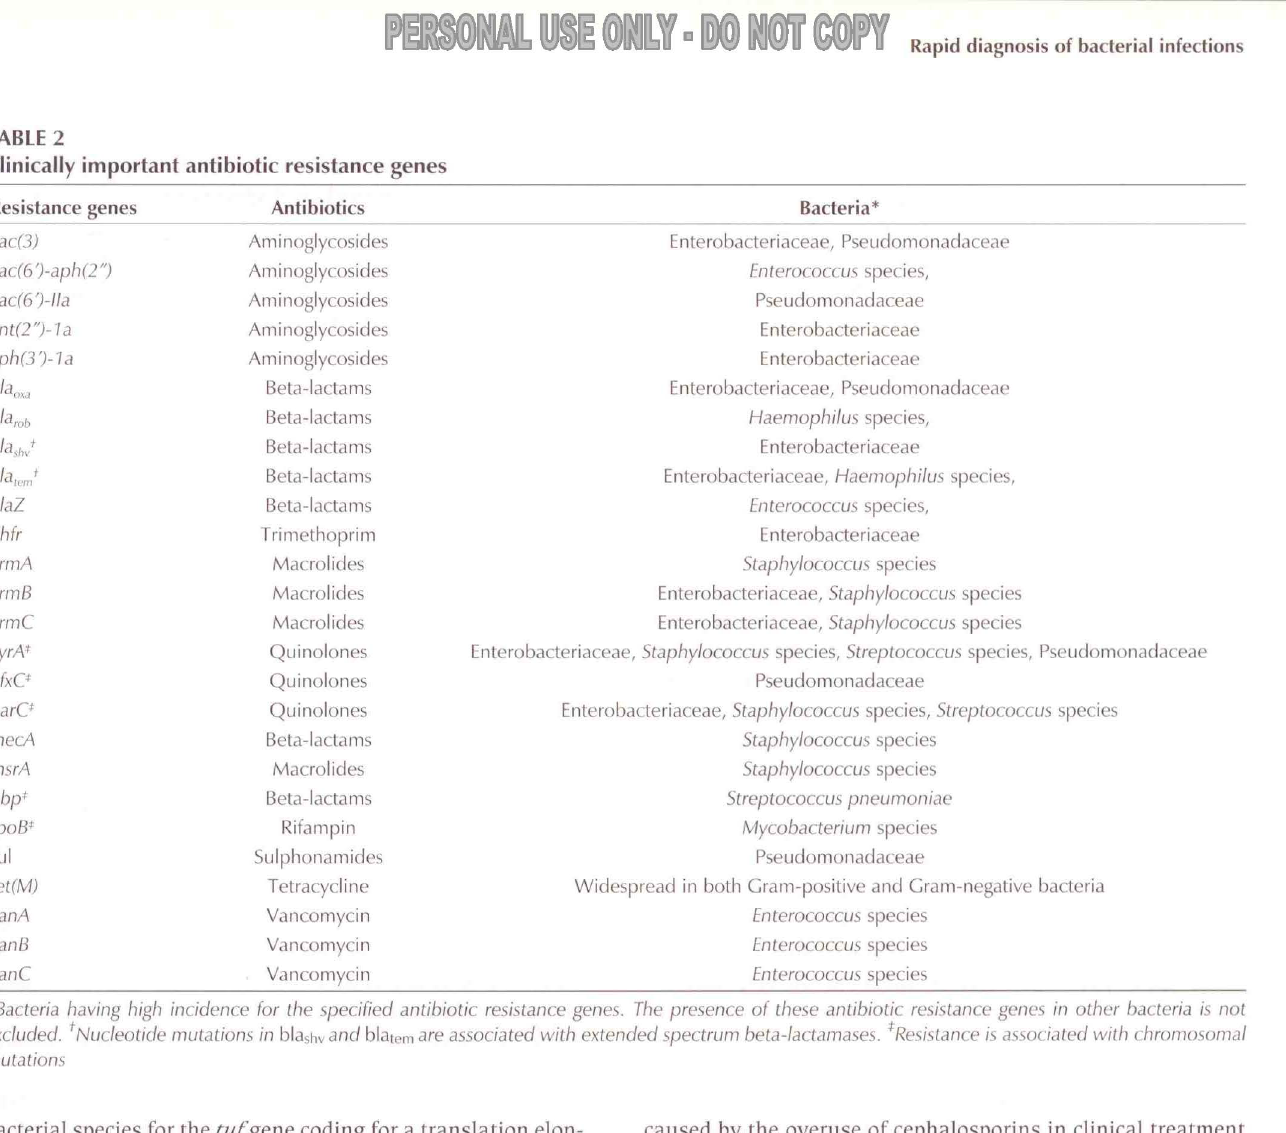
Clinically important antibiotic resistance genes Resistance